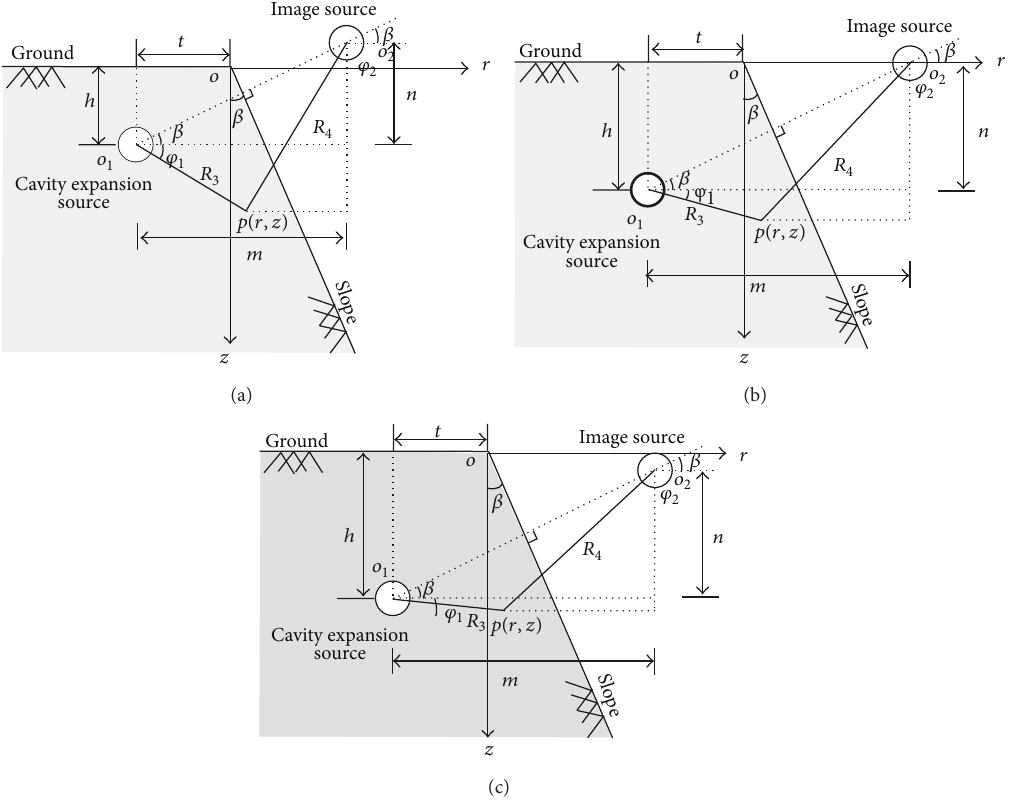
Figure 4: The expansion of the single spherical cavity near a slope. (a) The image source is located above the ground surface. (b) The image source is located on the ground surface. (c) The image source is located below the ground